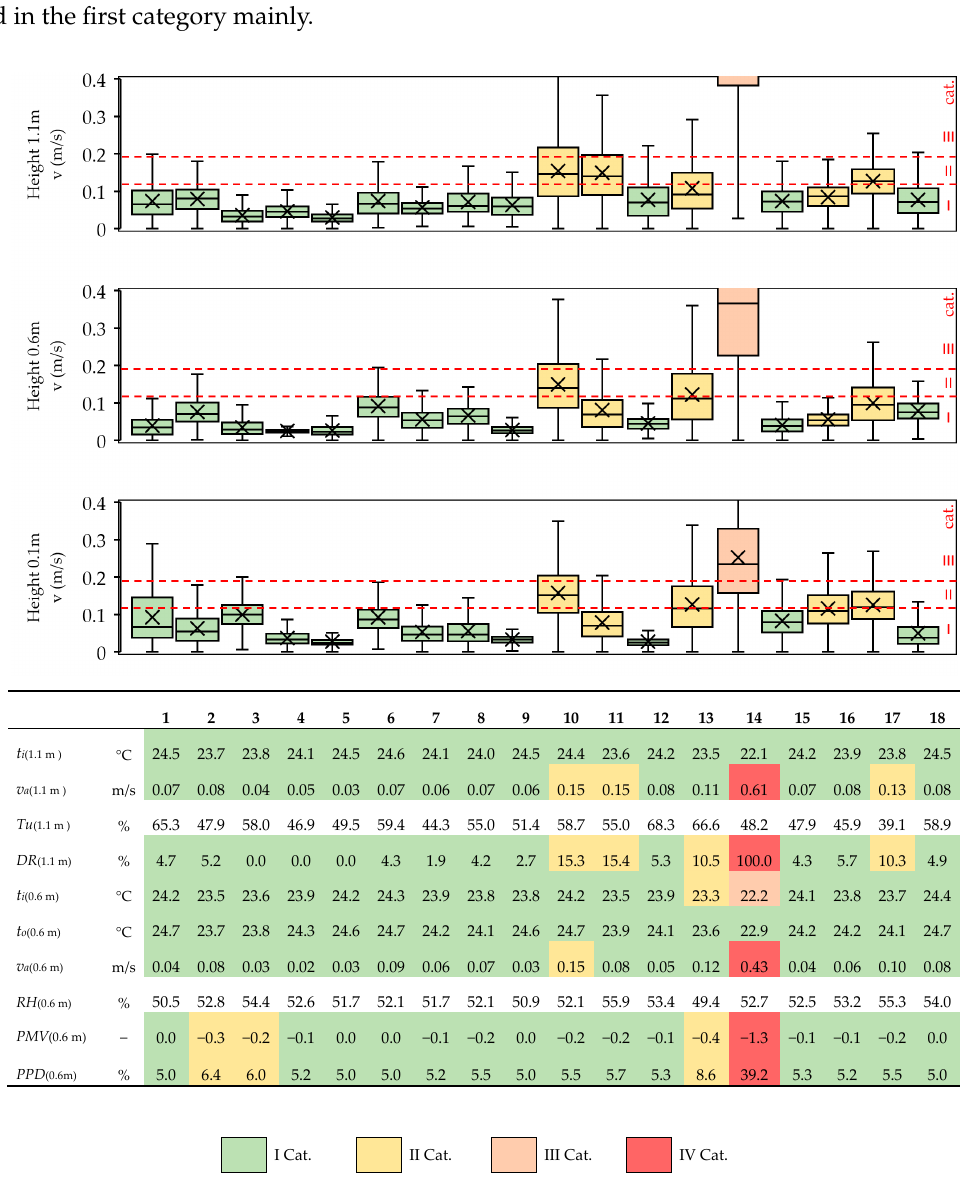
Figure 4. Building A air velocity results in measurement points 1–18 and the thermal comfort Figure4. parameters.